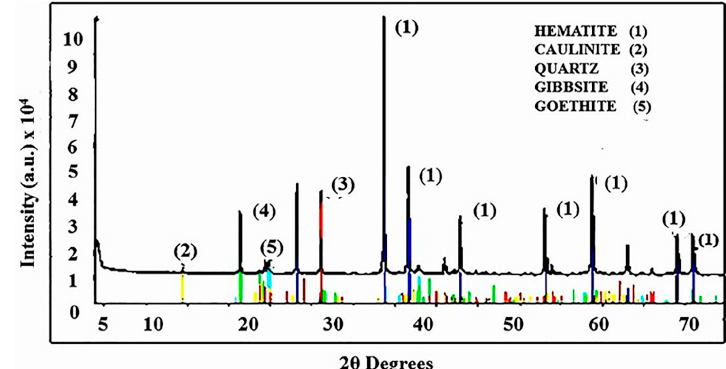
Figure 3. X-ray diffraction spectrum of the iron ore sample. Table 1. Levels used in factorial planning. Variables Granulometry